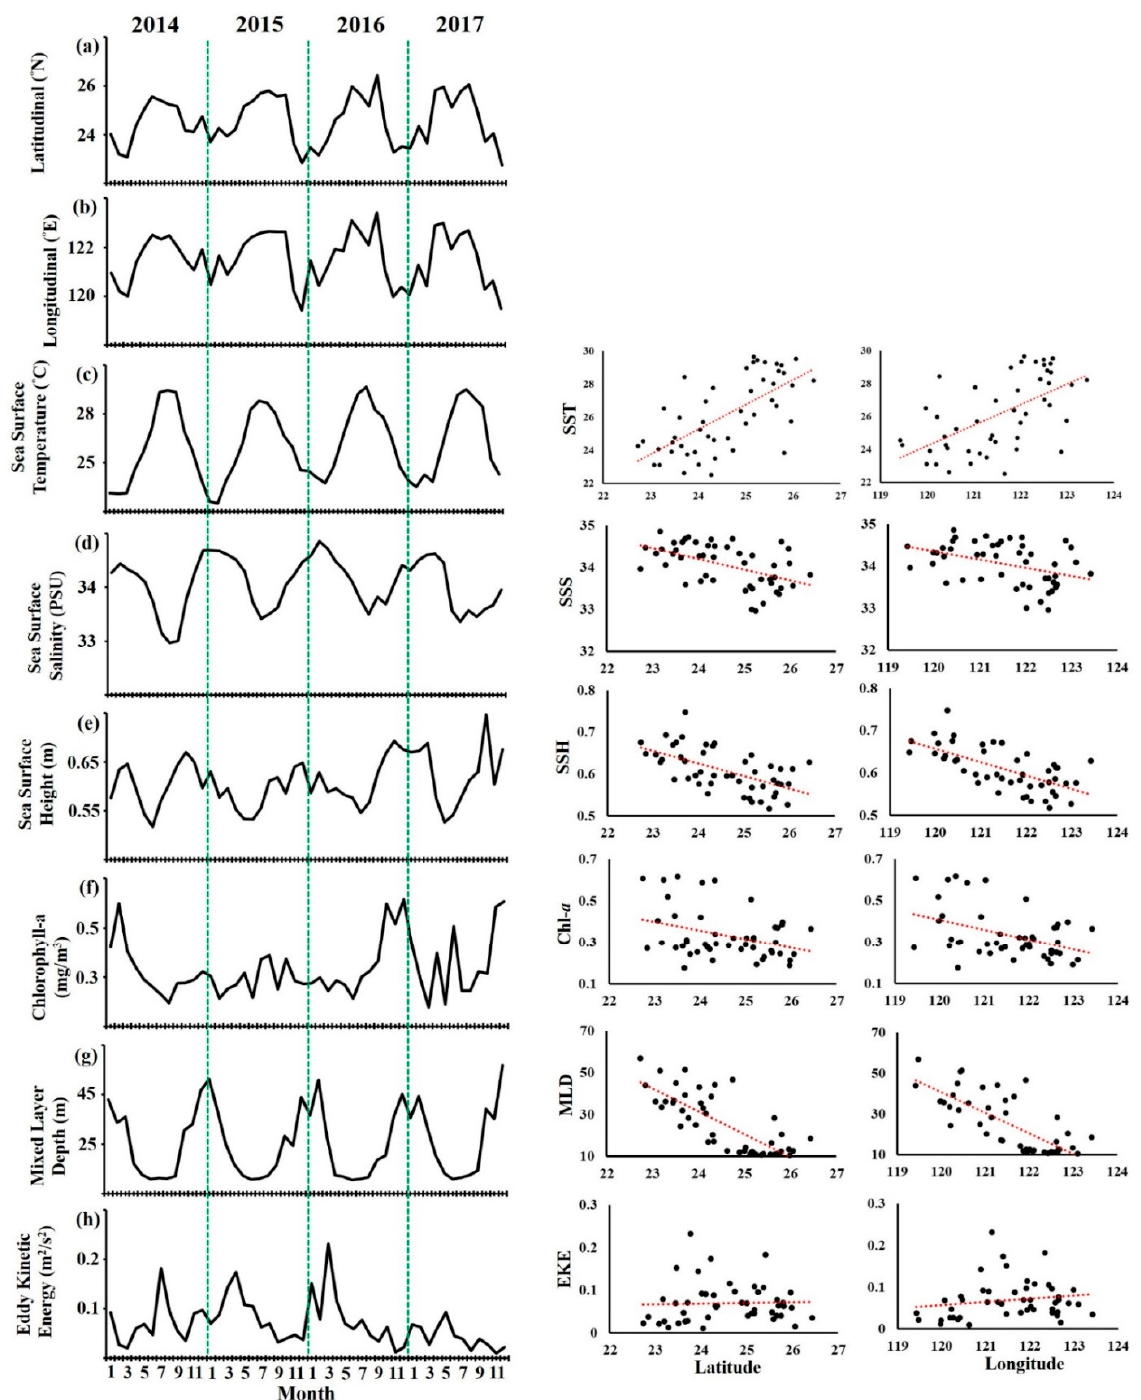
Figure 3. Monthly average trends in the time series of ( a ) latitudinal (Lat.) and ( b ) longitudinal (Lon.) gravitational centers of observed catch rates ( G ) compared with the monthly average values of ( c ) sea surface temperature (SST), ( d ) sea surface salinity (SSS), ( e ) sea surface height (SSH), ( f ) chlorophyll- a (Chl- a ), ( g ) mixed layer depth (MLD), and ( h ) eddy kinetic energy (EKE) in the TS. On the right side is the correlation between latitude and longitude in relation to all the environmental factors.